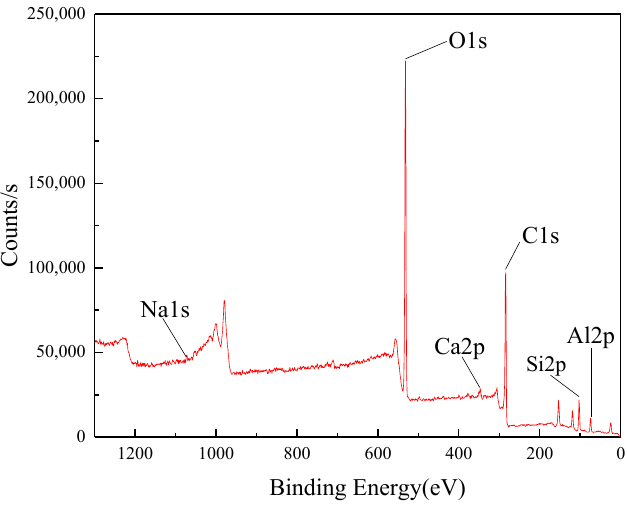
Figure 2. XPS survey scan result of coal sample.